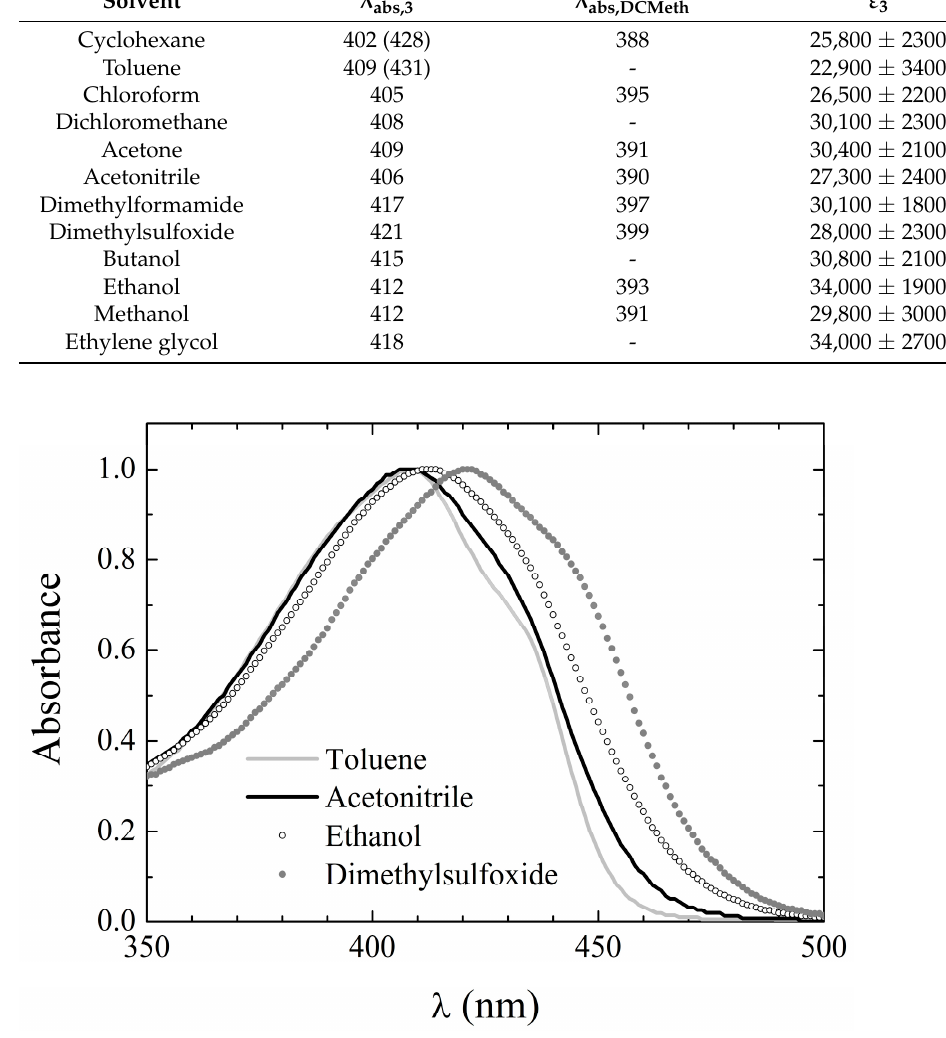
Figure 4. Absorption spectral line shape of 3 in exemplary solvents.